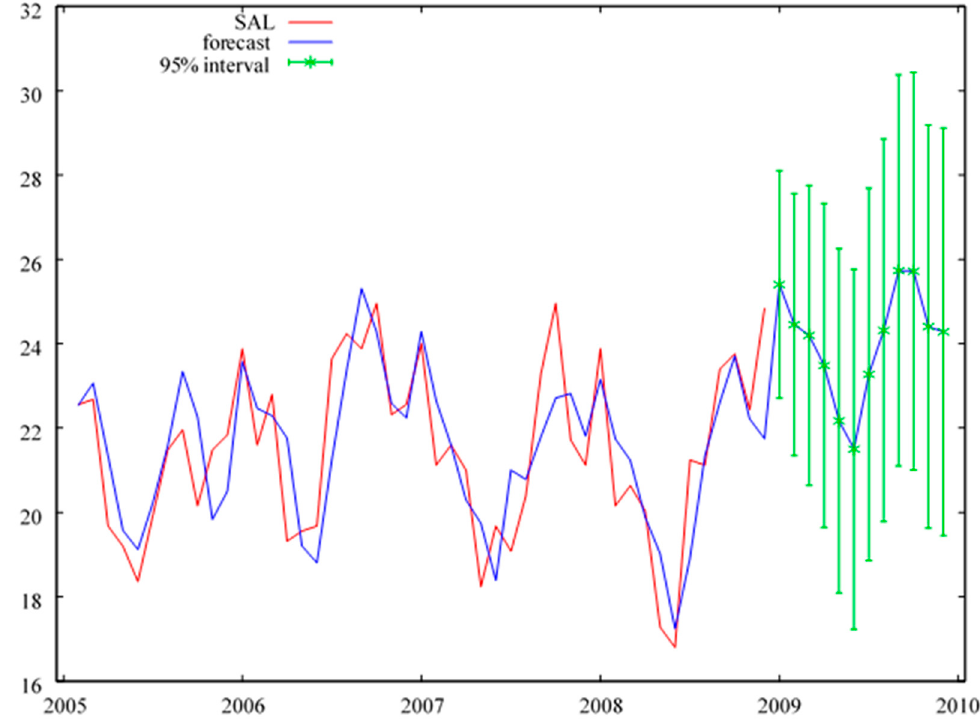
( s ) SAL for the year 2009, in a system with an increase in the initial value of for the year 2009, in a system with an increase in the initial value of SAL for the year 2009, in a system with an increase in the initial value of Tp Tp Tp